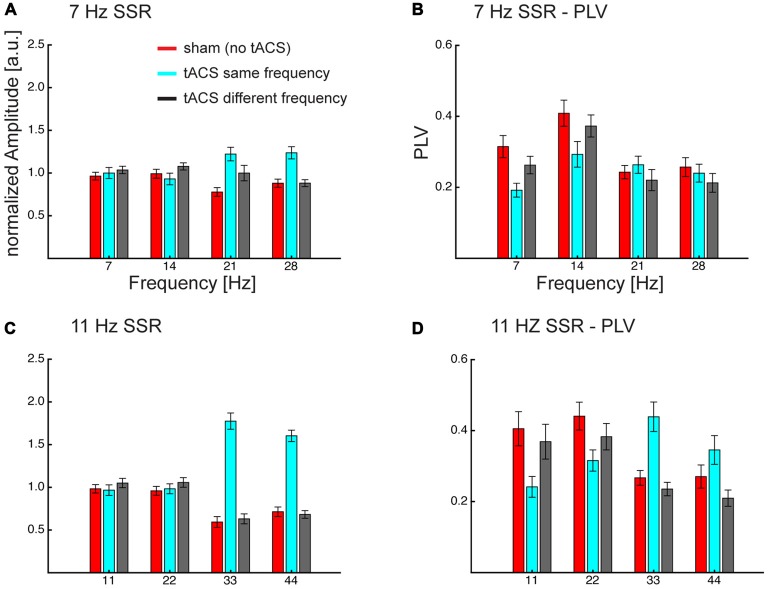
Grand average normalized amplitudes (A,C) and PLV (B,D) at the visual flicker driven fundamental (f = 7/11 Hz) and 3 harmonic (2f, 3f, 4f) frequencies. Frequency specificity of tACS can be seen in amplitude and PLV, also tACS seems to affect different parts of the flicker driven brain signal. Both measures show that same-frequency tACS is strongly enhancing the harmonics (3f, 4f) and PLV additionally shows a decrease in the lower harmonics. Overall this pattern seems to be more pronounced for 11 Hz SSRs. Note that neither fundamental nor harmonics seem to be affected when the tACS frequency differs from the flicker/SSR frequency. Error bars represent standard error of the mean.